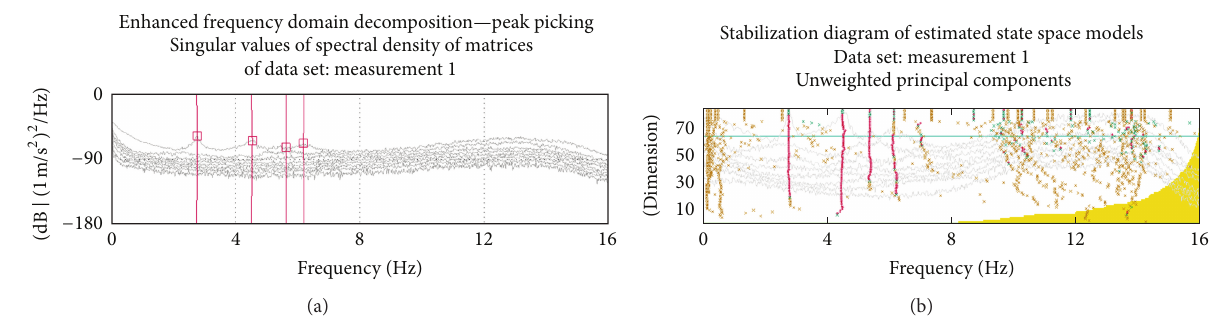
Figure 8: Uniaxial accelerometers and 17-channel data acquisition system.